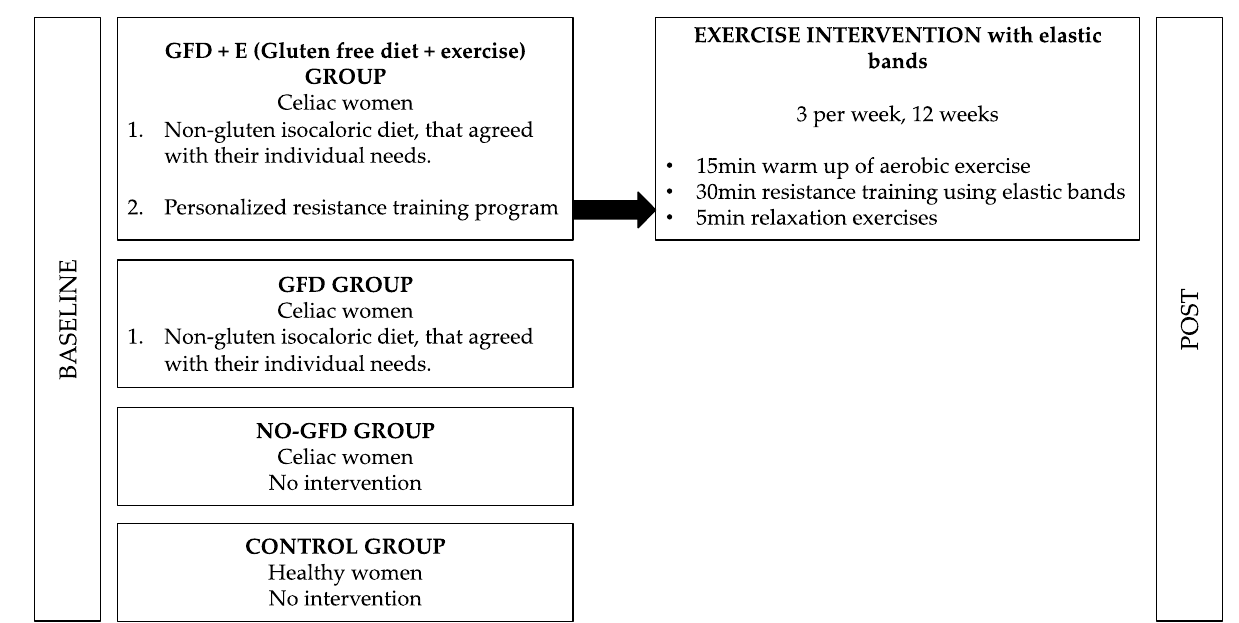
Figure 2. Different groups and interventions performed in the